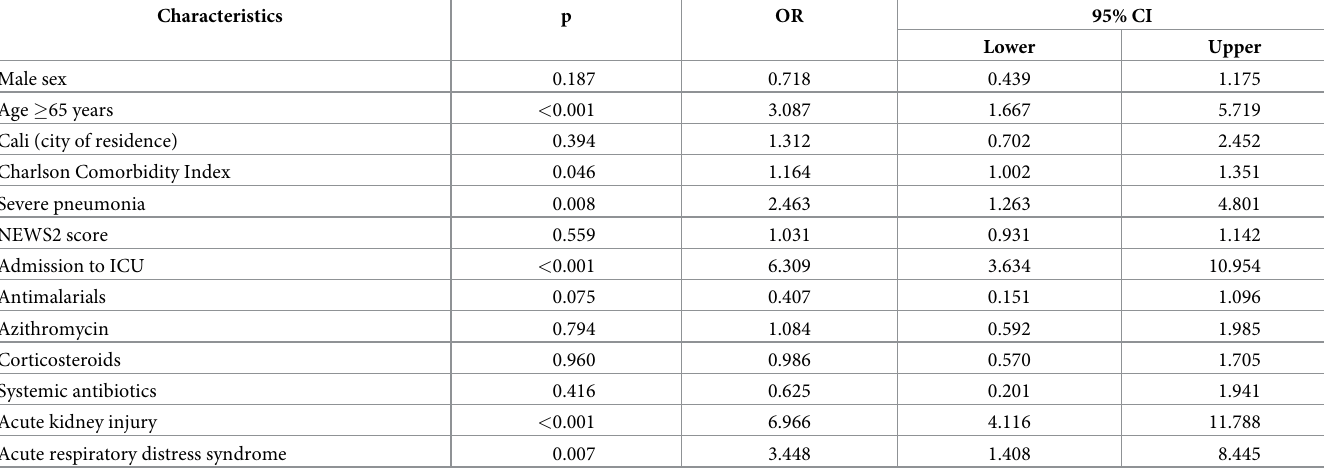
Table 6. Binary logistic regression of variables associated with the probability of dying in patients diagnosed with SARS-CoV-2. Characteristics p OR 95% CI